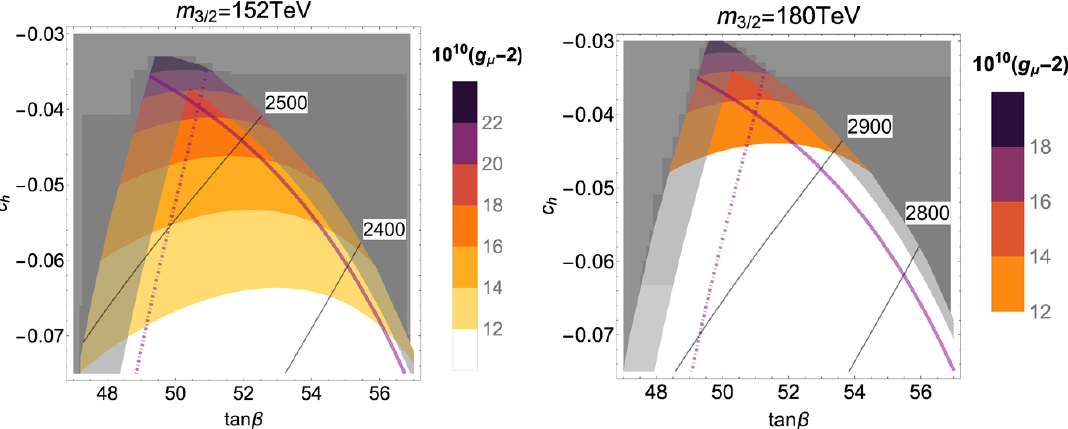
Figure 3 . Contours of the ratio of SUSY contribution to the experimental value of (cid:15) k for m 152 TeV(left) and m = 180 TeV(right). The gray shaded regions denote the LHC bounds. On 3 = 2 the purple dash-dotted (solid) line, the mass of the right (left)-handed selectron degenerates with the wino mass. On the black dash-dotted line in the right panel, the mass of the lightest squark degenerates with the wino mass. Below (Above) the blue (green) solid and dashed lines, the result is consistent with (cid:15) exp k